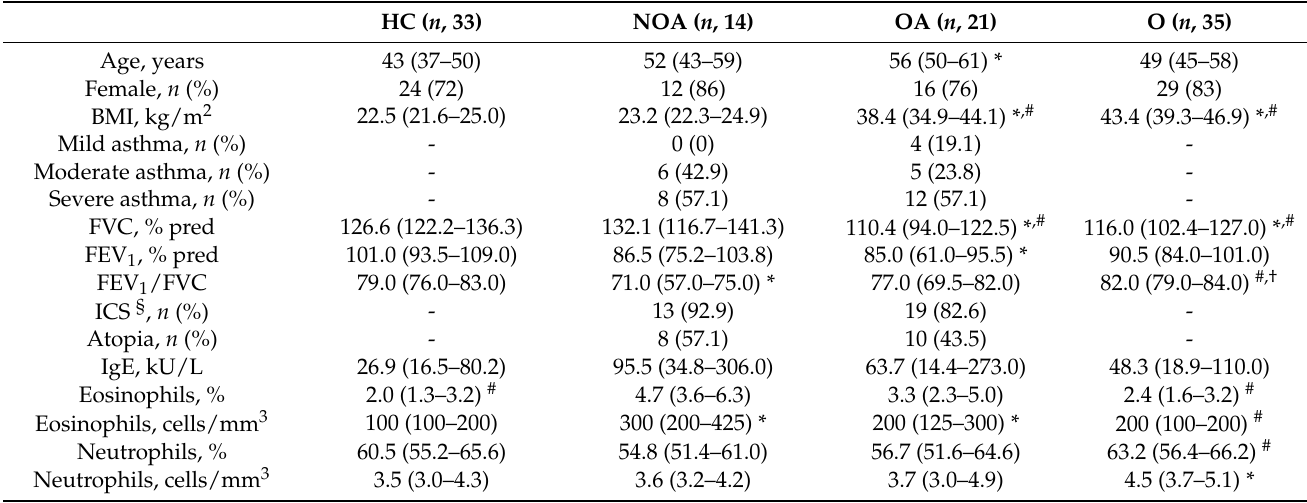
Table 1. Baseline demographic and clinical data of the study population.